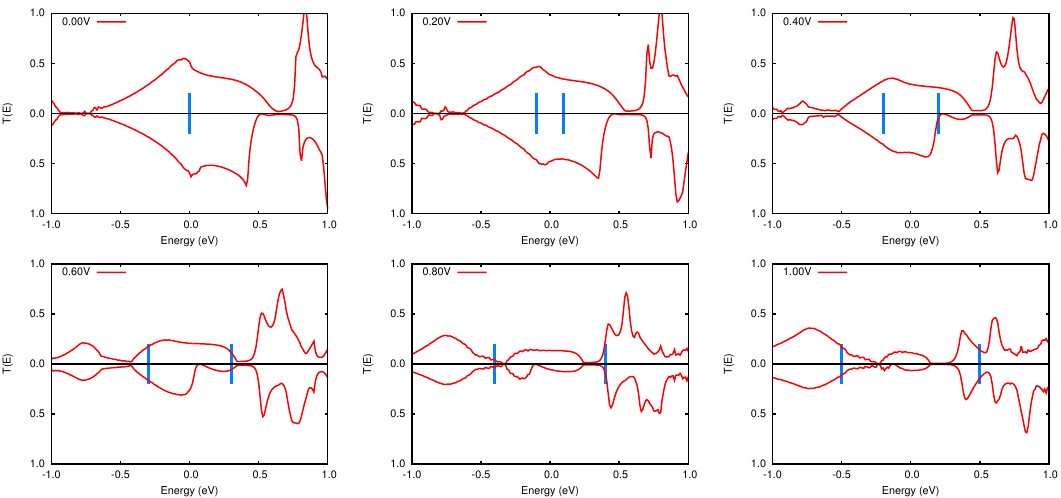
Figure 9. Transmission functions for the different applied biases in the N-doped FeP junction. The blue lines represent the bias